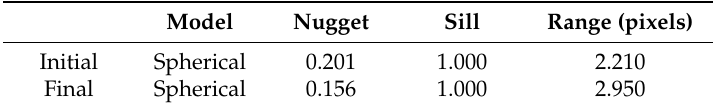
Table 5. Variogram parameters estimated based on standardized residuals of logistic regression. Model